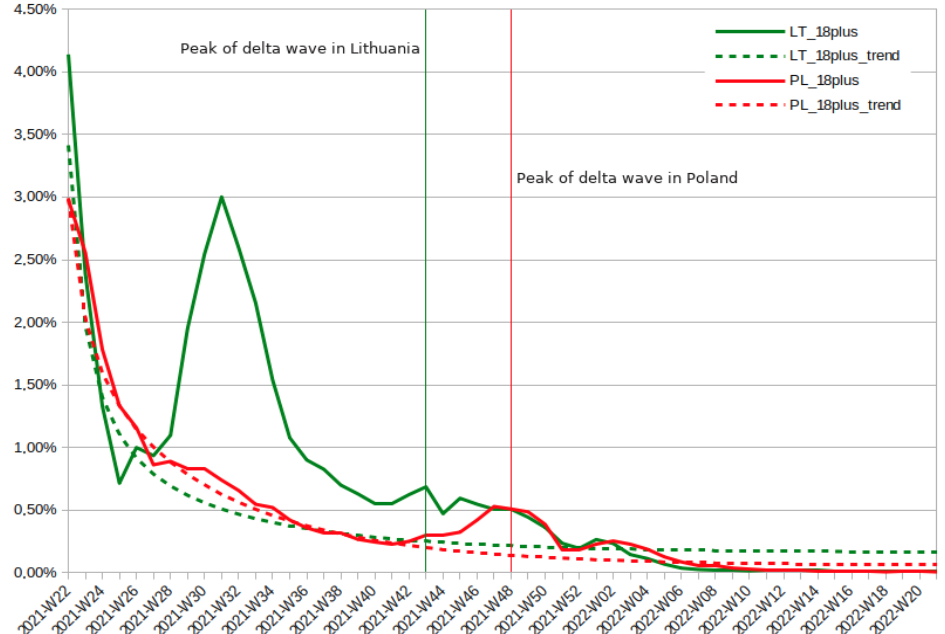
Figure 1. Percentage of Polish and Lithuanian adult population that received the first dose of COVID-19 vaccine in the period 2021-W22 to 2022-W21.